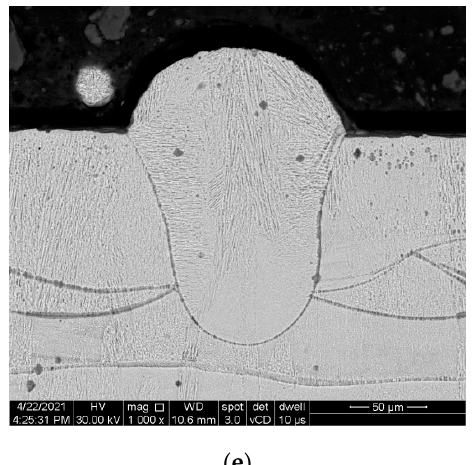
Figure 4. Cross-section SEM images of the single-track specimens built with different defocusing distance: ( a ) − 0.5 mm, ( b ) − 0.3 mm, ( c ) 0 mm, ( d ) 0.3 mm, and ( e ) 0.5 mm.